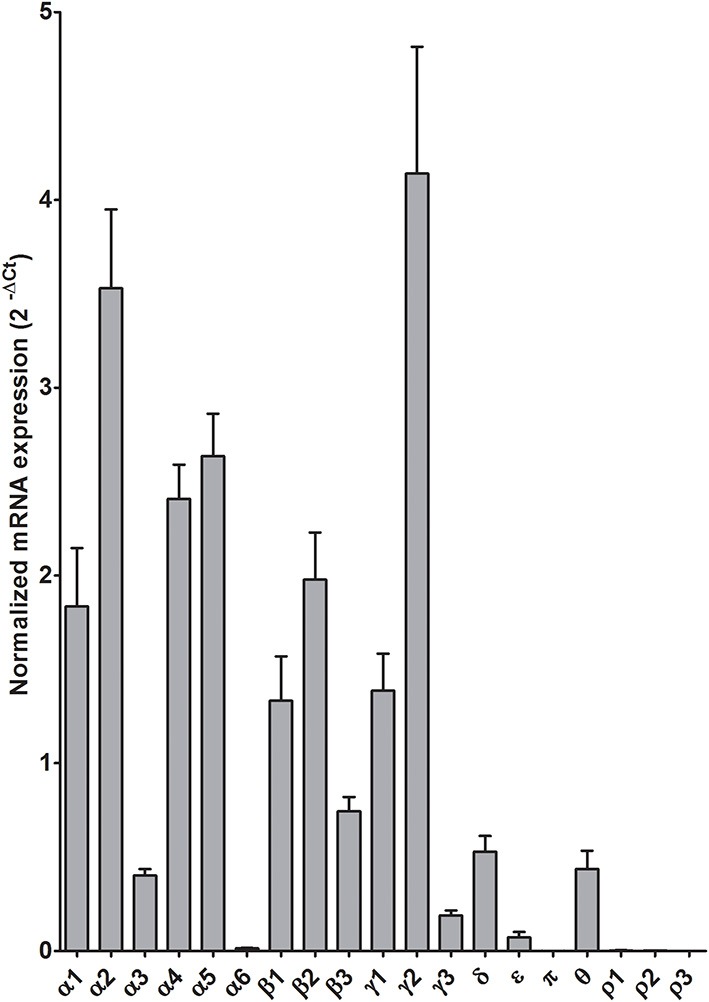
Expression of GABA-A receptor subunit mRNAs in the central amygdala of control subjects (n = 9). The mRNA level of each subunit was normalized to reference genes PGK1 and TBP and presented as mean ± standard error of the mean (SEM).